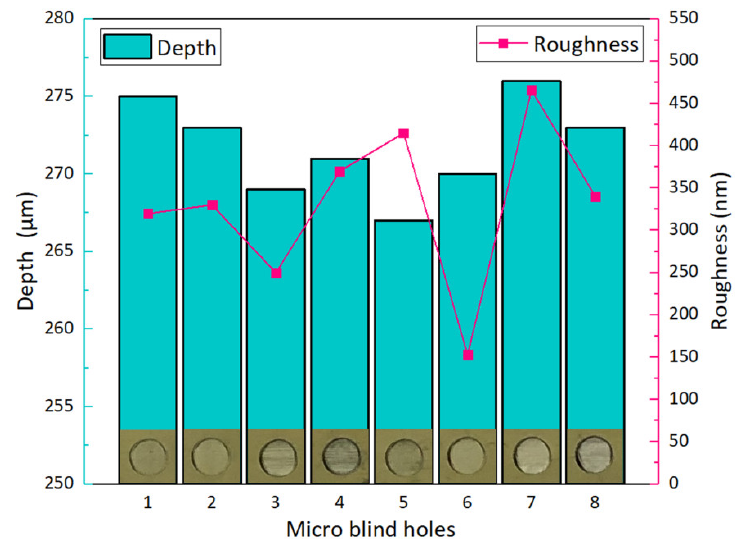
Figure 7. Depth and roughness of micro blind holes, which were all processed with the same set of parameters: laser average power of 1.5 W, lap of 15 and laser scanning speed of 125 mm/s.